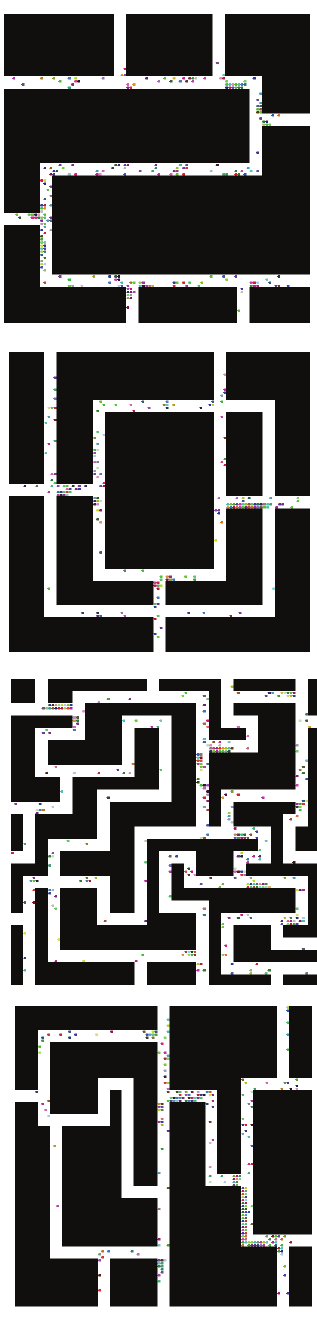
Fig. 10. Simulation